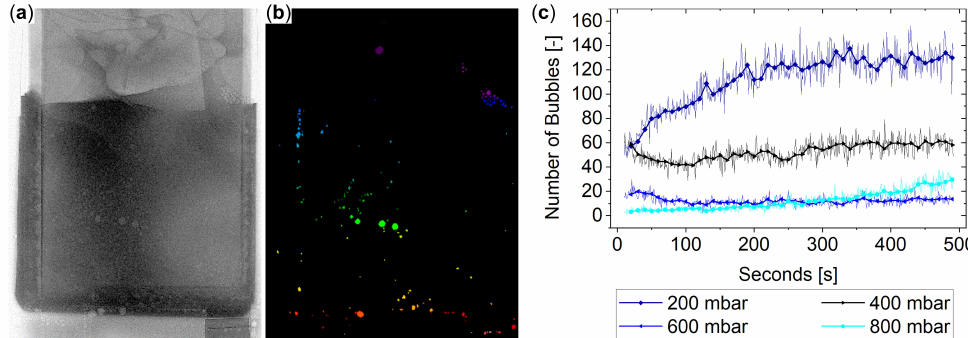
Figure 10. Detection of bubbles in X-ray images (200mbar, 400s shown here); ( a ): Sampled and preprocessed X-ray image. ( b ): Detected bubbles. ( c ): Number of bubbles over time for 200mbar, 400mbar, 600mbar and 800mbar chamber pressure. The pale colors show raw measurements while the thick lines show averages over 10 s intervals (non-sliding).